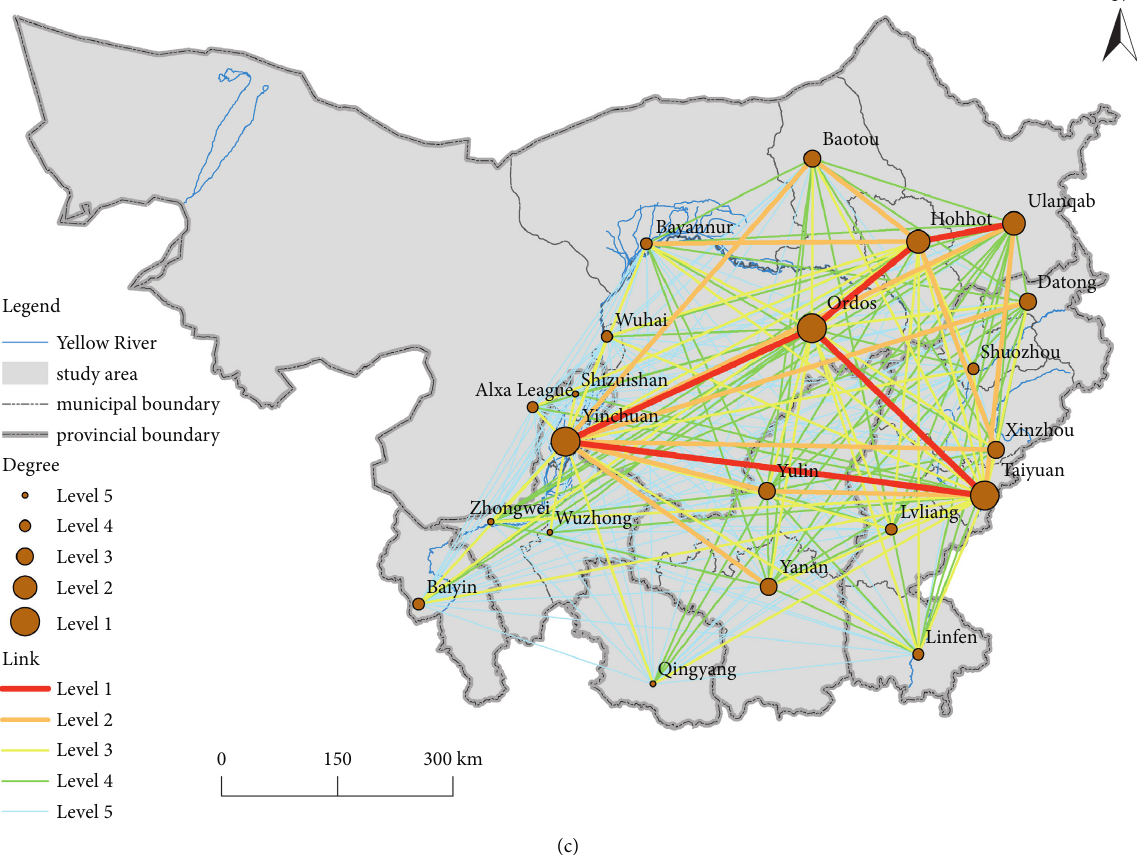
Figure 2: Functional linkage intensities of the three different flows: (a) population flow; (b) logistics flow; (c) information flow.